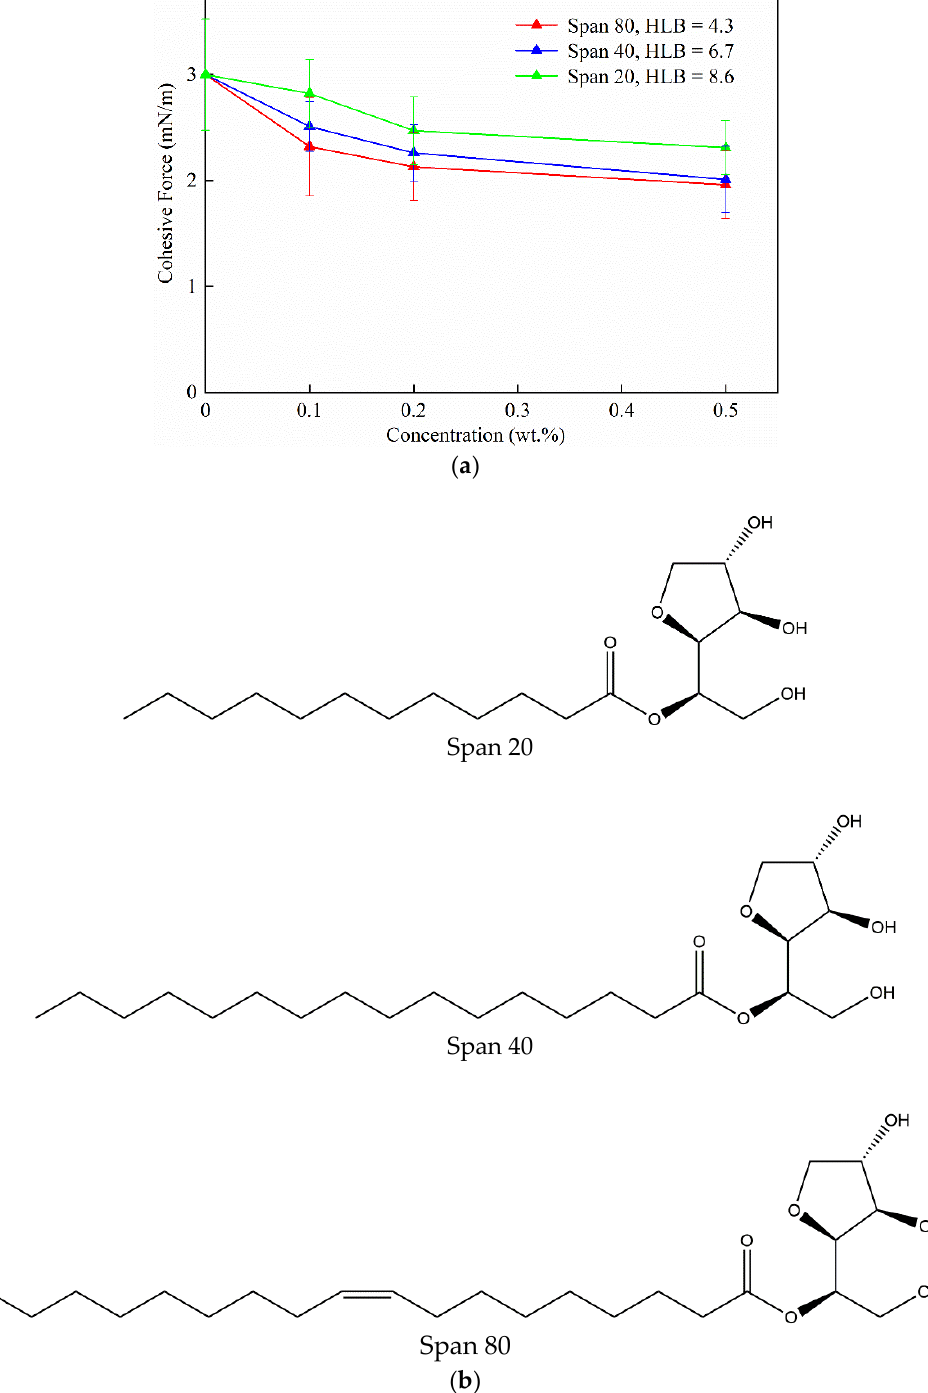
Figure 3. ( a ) Variation of cohesive force between hydrate particles with the concentration of Span surfactants (−1 °C, 2.2 mN/m, 10 s) ; ( b ) molecular structure diagram of Span series surfactants.